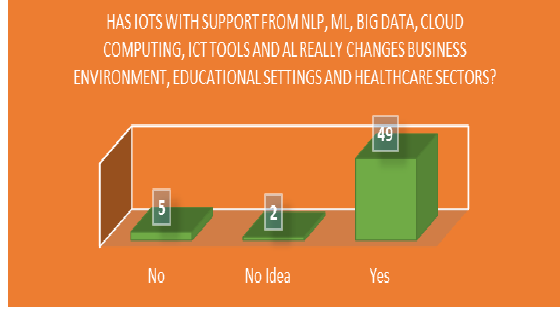
Figure 10. question three “Has IoTs with support from NLP, ML, Big data, cloud computing, ICT tools and Al really changes business environment, educational settings and healthcare